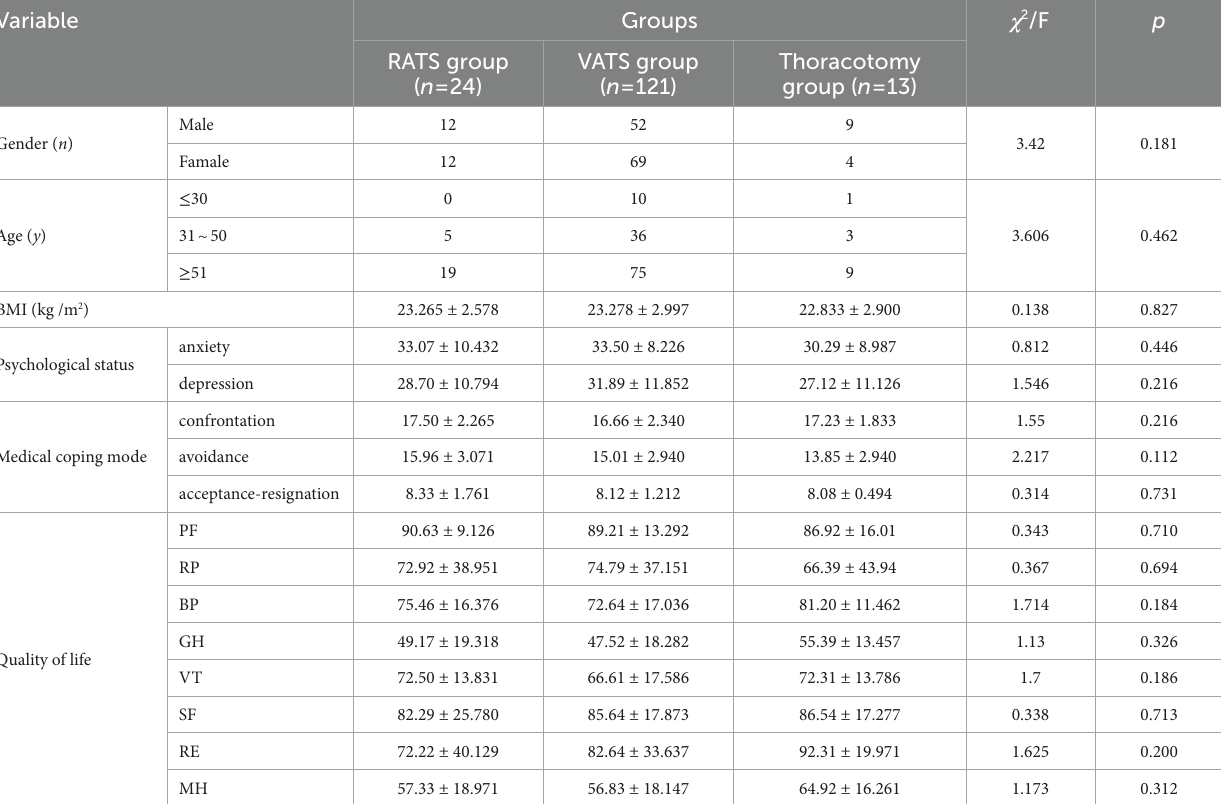
TABLE 1 Comparison of general data of three groups of patients. Variable